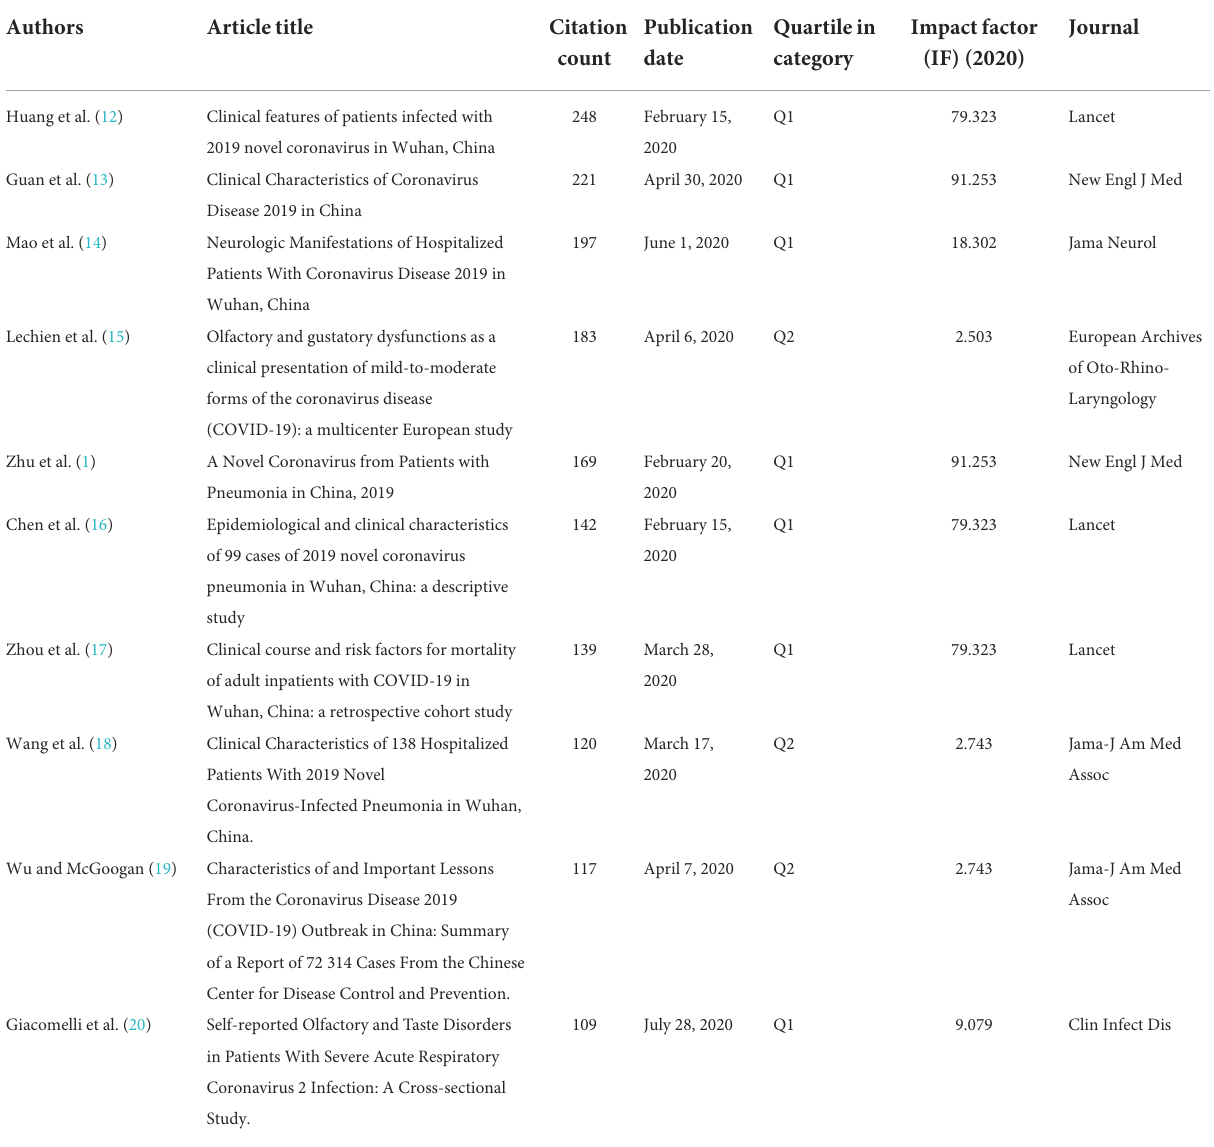
TABLE 4 Top 10 most frequently cited